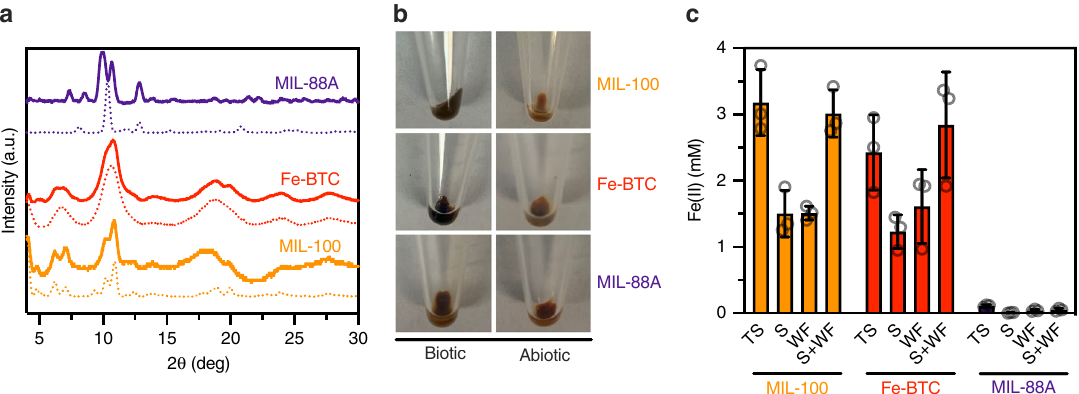
Fig. 4 Stability of metal-organic frameworks in the presence of S. oneidensis . a As-synthesized (dashed lines) and post-reduction (solid lines) PXRD patterns of MIL-100, Fe-BTC, and MIL-88A. b Images of biotic and abiotic treated MIL-100, Fe-BTC, and MIL-88A after 48 h. c Fe(II) concentrations as measured in the total suspension (TS), isolated supernatant (S), and isolated/washed framework (WF). The sums of the isolated supernatant and isolated/ washed framework are also shown (S + WF). Data shown are mean ± S.D. for three independent biological replicates. Source data for a and c are